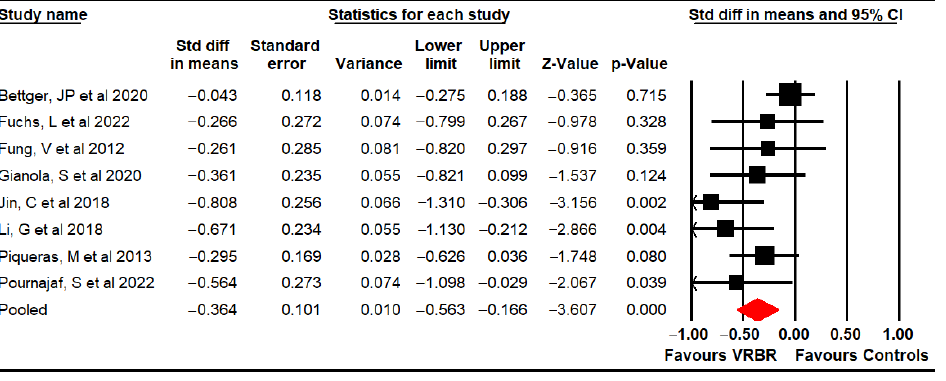
Figure 2. Forest plot of the immediate effect of VRBR on knee pain